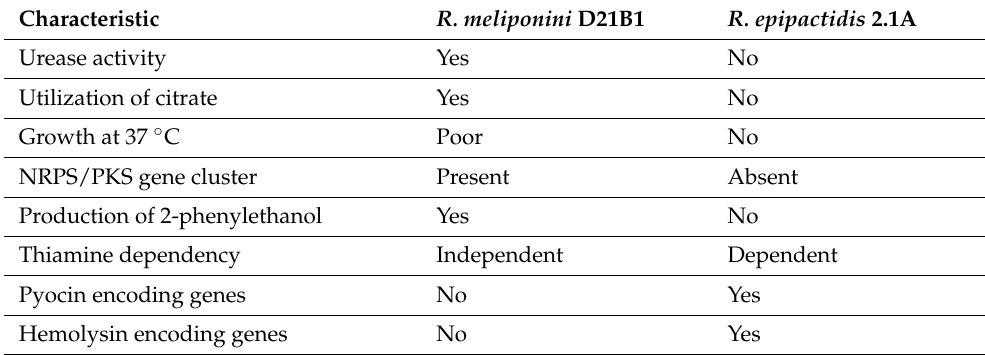
Table 3. Major physiological, biochemical, and genetic differences between Rosenbergiella meliponini D21B and its nearest relative, R. epipactidis